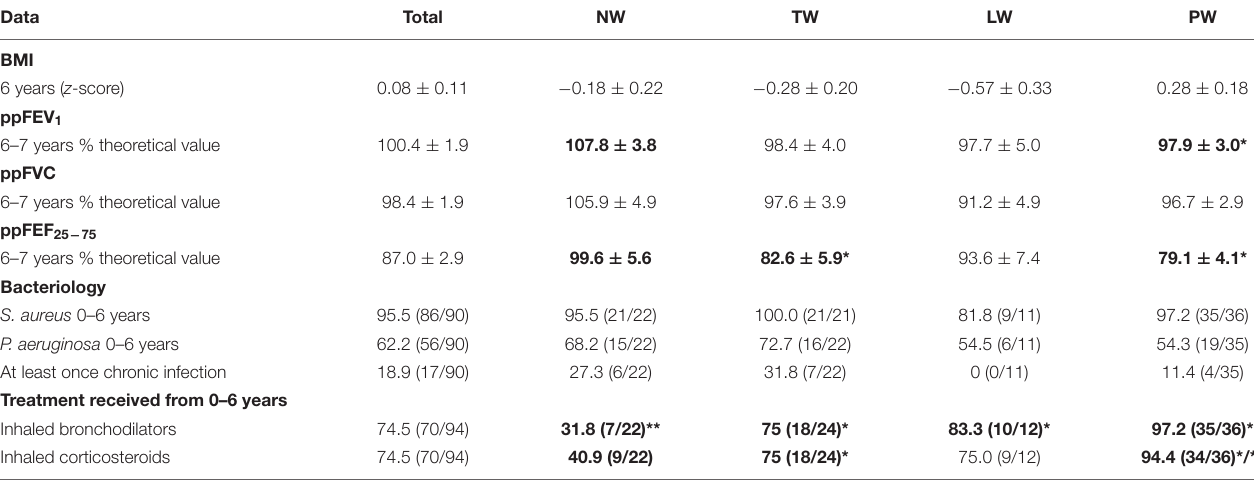
TABLE 2 | Consequences of pre-school wheezing according to the TUCSON